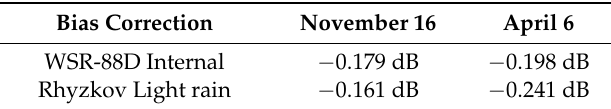
Table 2. WSR-88D Internal vs. External Bias